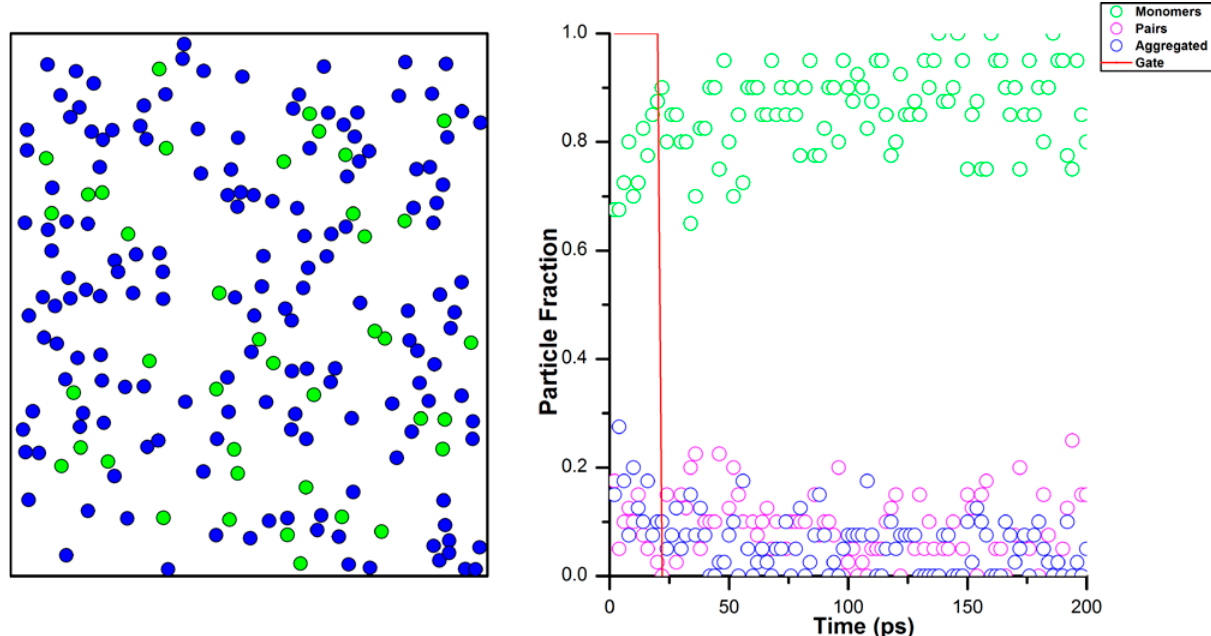
Figure 4. Left: snapshot of the configuration obtained after 200 ps of a simulation for the mixture described in Figure 3 at T = 300 K and no interactions between the particles. Right: time evolution of the fraction of B monomers, pairs of B atoms and total aggregated B atoms present in clusters of more than 2 B atoms for the same simulation. The time at which the red line sharply drops to zero indicates when the gate shown in Figure 3 was opened and the particles were allowed to mix. The MD time step was 1